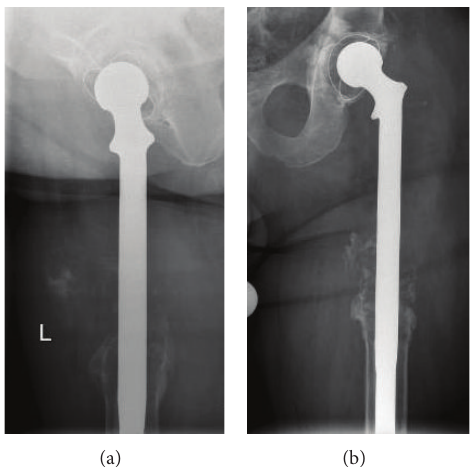
Figure 3: (a) Radiographs showing ectopic ossification on the lateral view revealing local recurrence. (b) AP view.